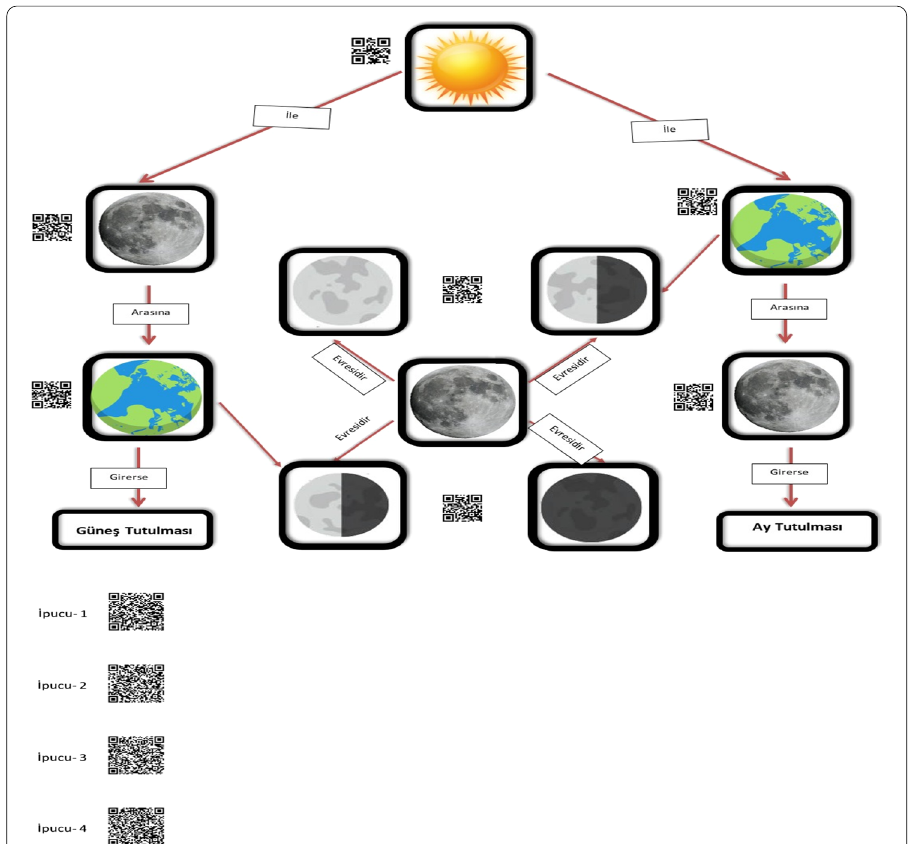
Fig. 5 A view from S11 having errors in